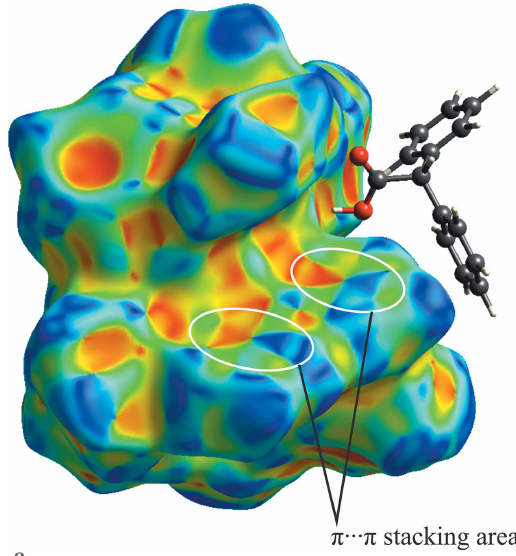
Figure 8 Hirshfeld surface of compound 2 plotted over